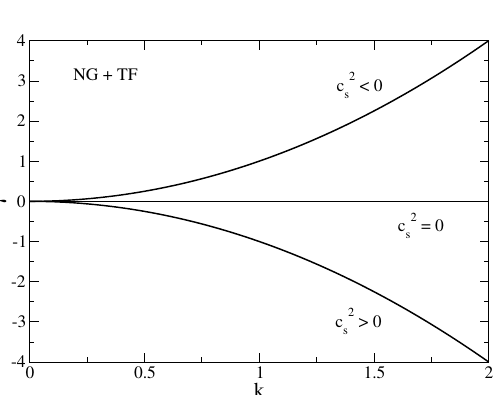
Figure 7. Exponential rate for overdamped BECs in the nongravitational + TF limit ( G = ¯ h = 0). > 0, the perturbation decays exponentially rapidly ( γ < 0). The system is stable for all When c 2 s modes k .